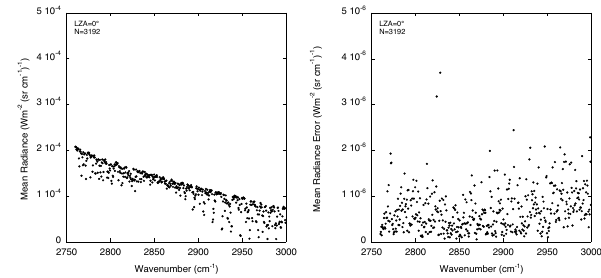
Figure 6. The mean NIR radiance spectrum based on all LBLRTM simulations performed with the 3192 radiosonde profiles (left), and the spectral radiance estimation errors (regression rms errors) asso- ciated with them (right). All simulations shown are for a local zenith angle of 0 ◦